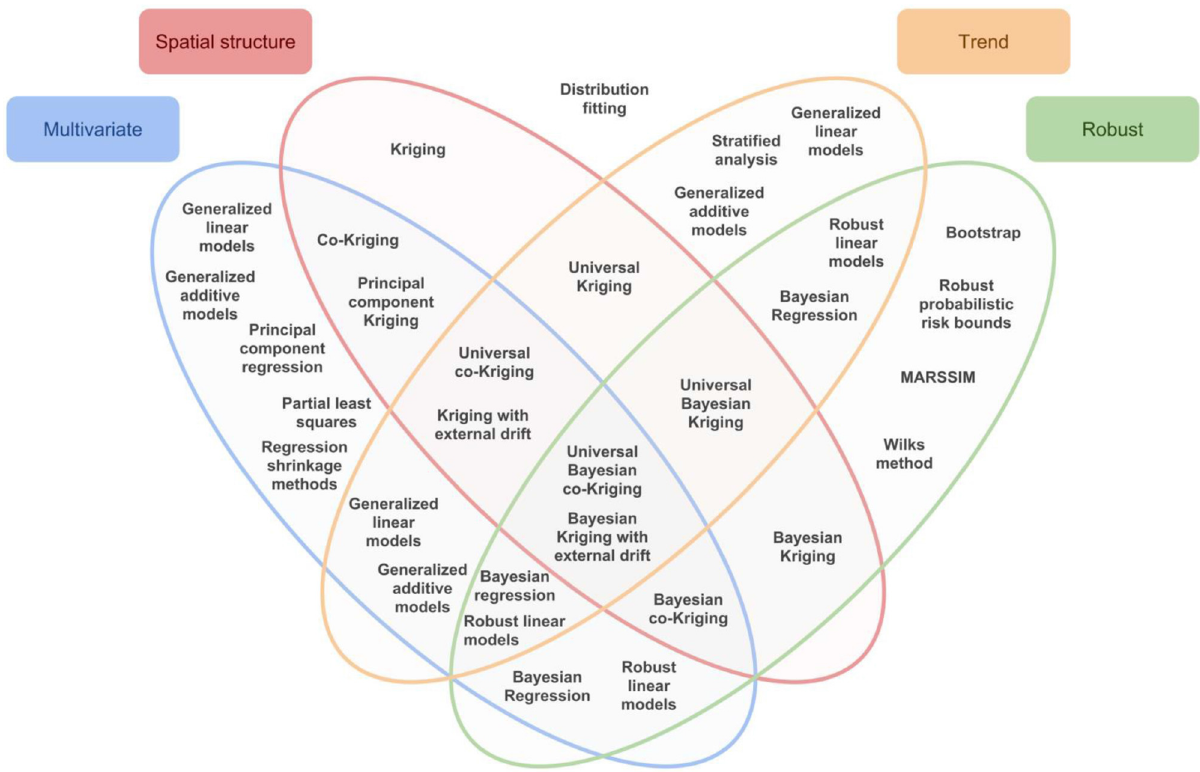
Fig. 3. Data analysis Venn diagram.